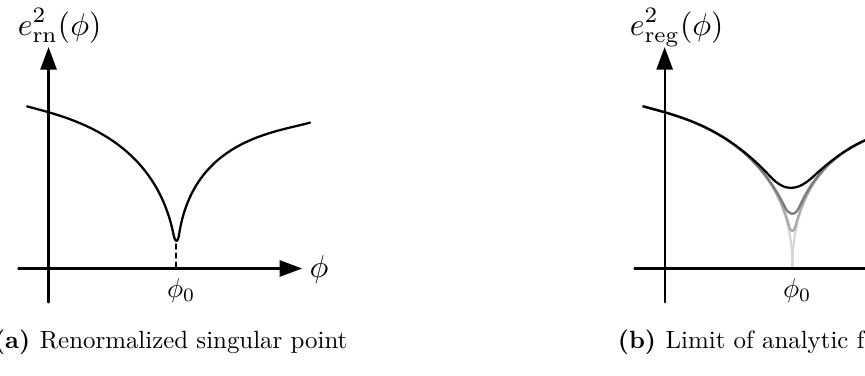
Figure 3. (a) The gauge coupling renormalized at the scale of the horizon radius avoids the singular behavior at φ = φ 0 . (b) The non-analytic behavior near a singular point can be described as the limit of a sequence of analytic functions, appropriate to the large black hole